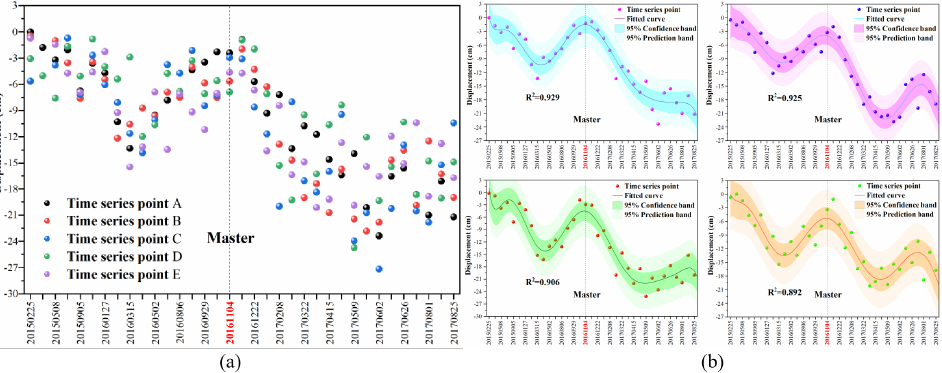
Figure 5. Variation of displacement time series of high coherence on the mountaintop: ( a ) displace- ment time series change; ( b ) displacement time series of fitted